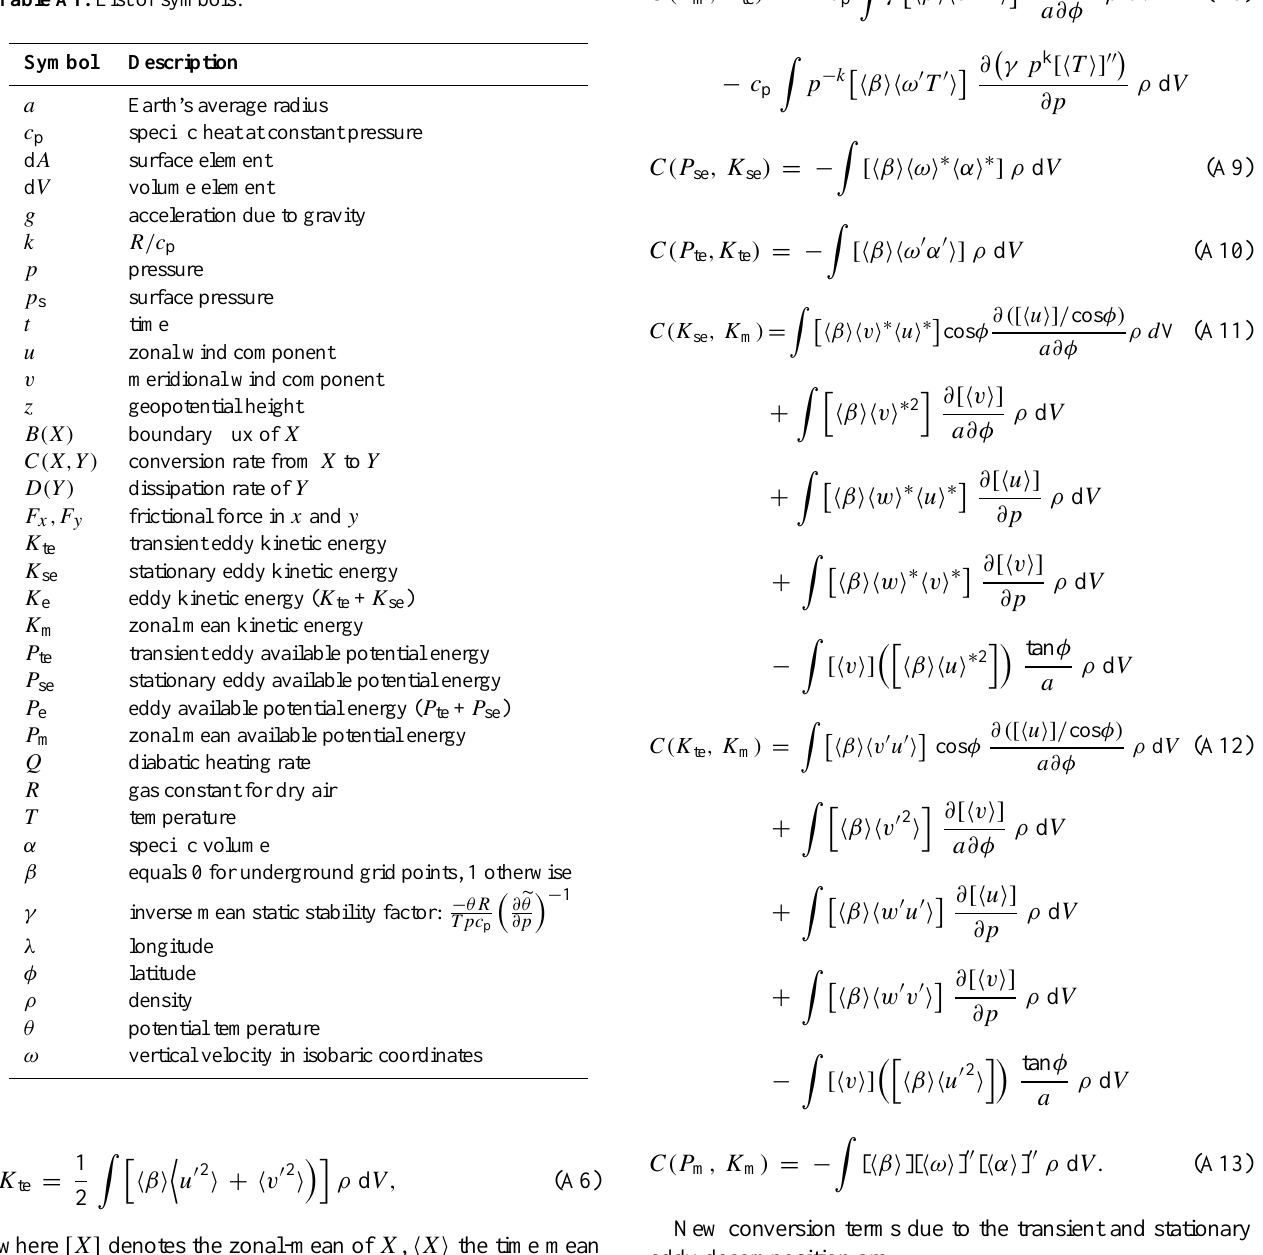
Table A1. List of